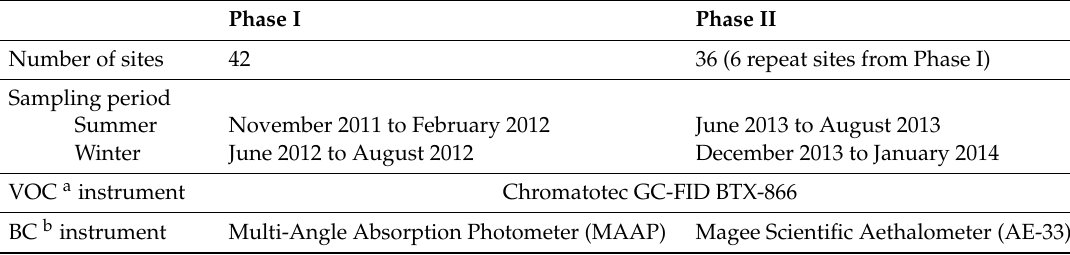
Table 1. General information for the two phases of measurements in this